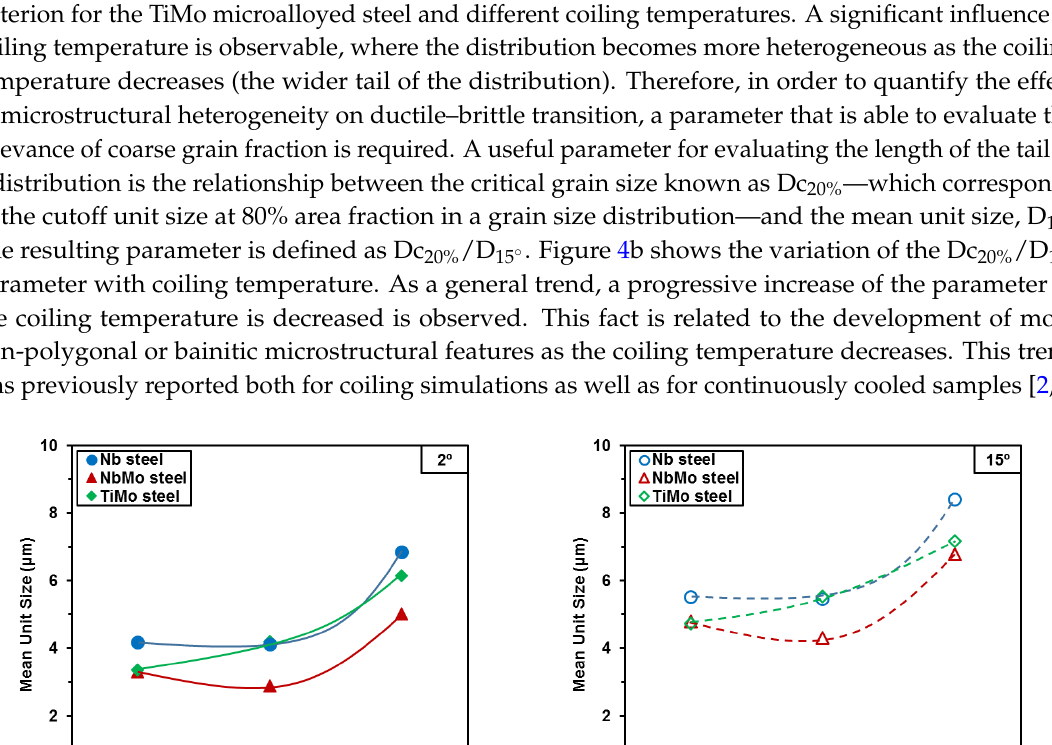
( a ) ( b ) Figure 4. ( a ) Accumulated area fraction using a 15° misorientation criterion for the TiMo steel; and ( b ) evolution of the Dc 20% /D 15° parameter as a function of the coiling temperature. 3.1.2. Dislocation Density In addition to quantifying unit sizes, strengthening due to dislocation networks has to be considered, as the progressive modification from ferritic to bainitic microstructures is relevant when coiling temperatures decrease. The dislocation density has been inferred using the Kernel Average Misorientation (KAM) parameter measured using EBSD. KAM reflects the local misorientation gradients within a given region. For that purpose, the approach proposed by Kubin and Mortensen is adopted (see Equation (2)) [10]. ρ = 2𝐾𝐴𝑀 𝑏𝑢 (2) where b is the Burgers vector and u is the length related to the Kernel. The KAM for ϑ < 2 ° and the second neighbor distance have been predefined to calculate the parameter. In the current work, the length associated with the Kernel parameter ( u ) is 1.86 times the step size. With the aim of minimizing the frequent overestimation of the Kernel as determined by means of conventional EBSD, the measurements have been corrected using a recently proposed correlation between high-resolution